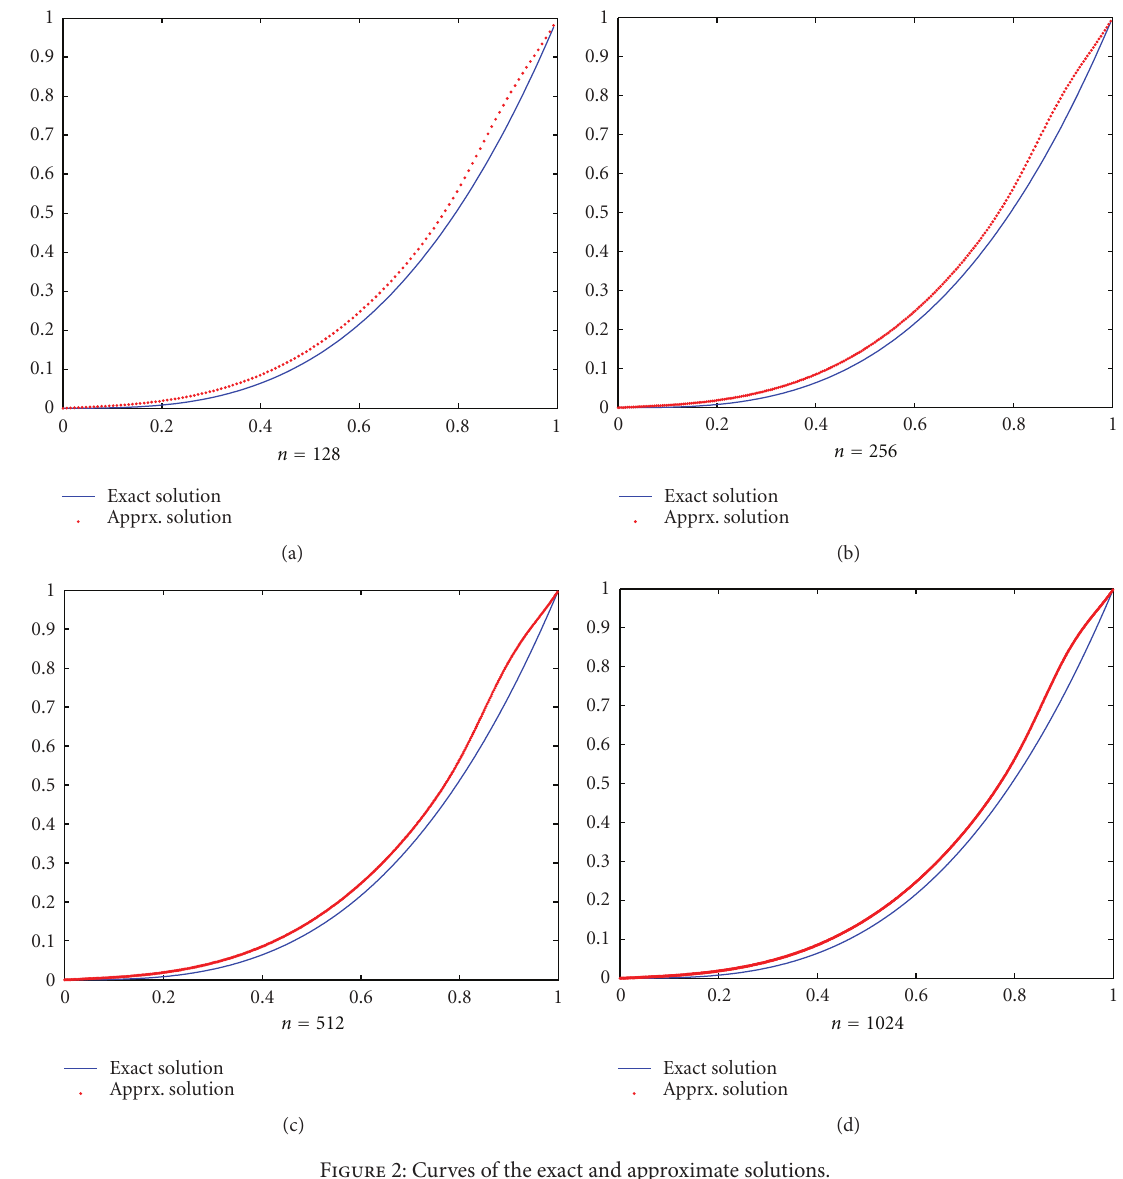
Figure 2: Curves of the exact and approximate solutions.